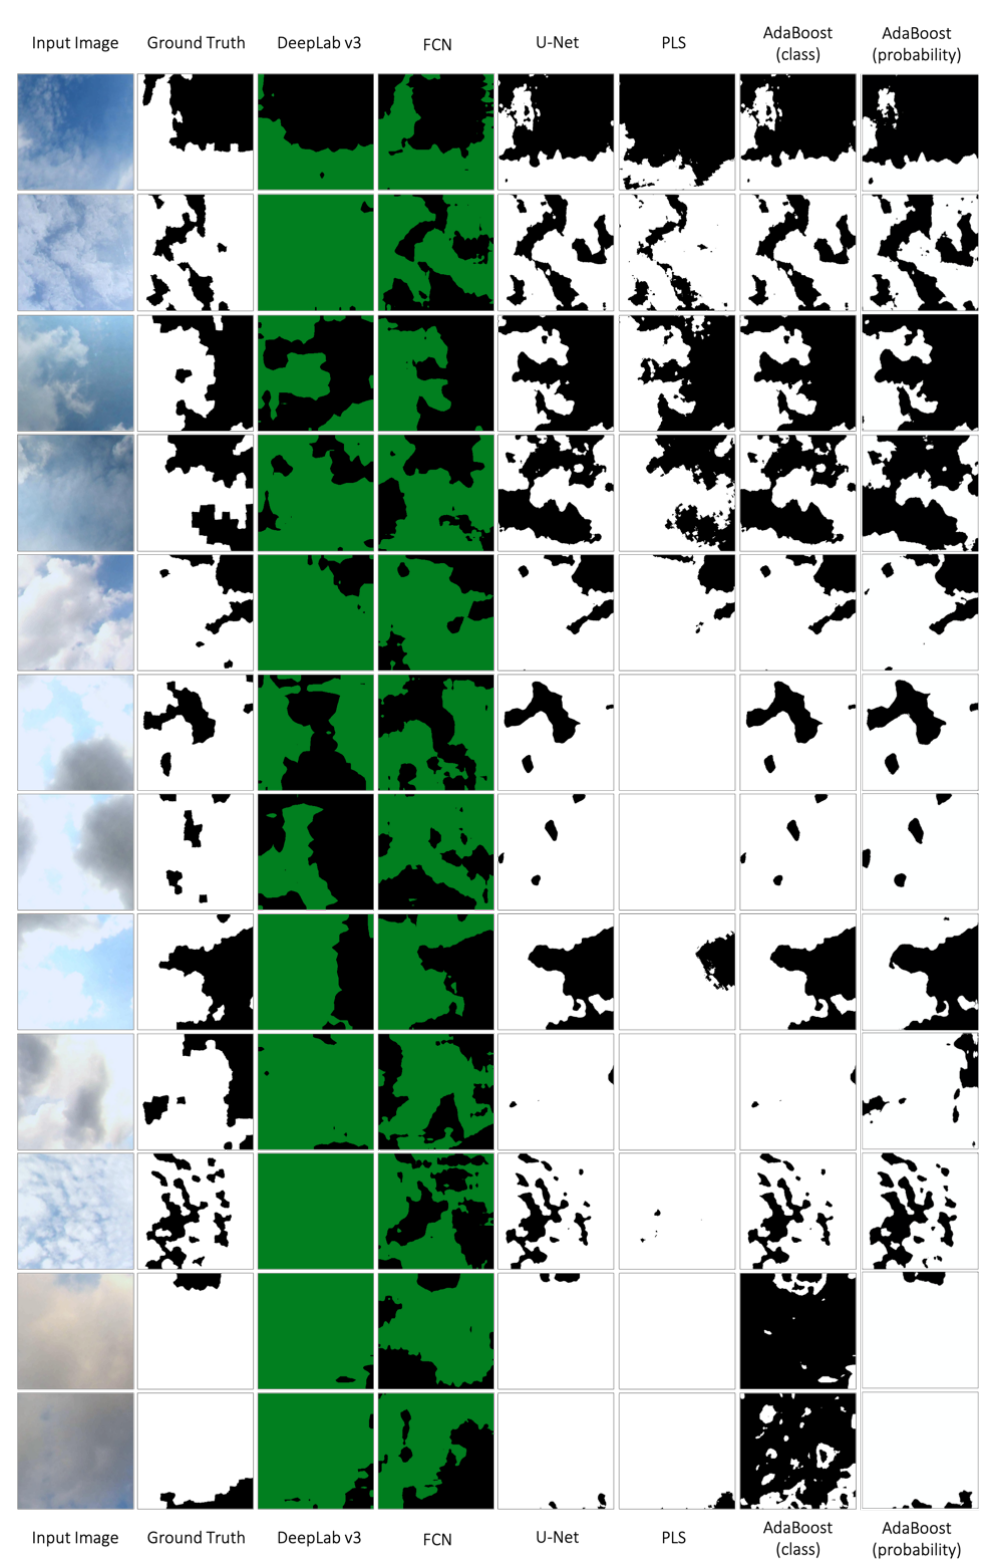
Figure 3. Cloud segmentation results from the six machine learning models along with input and ground truth images. From the right, the images are input; ground truth; and results from DeepLab v3, FCN, U-Net, PLS, AdaBoost trained with class number, and AdaBoost trained with normalized cloud